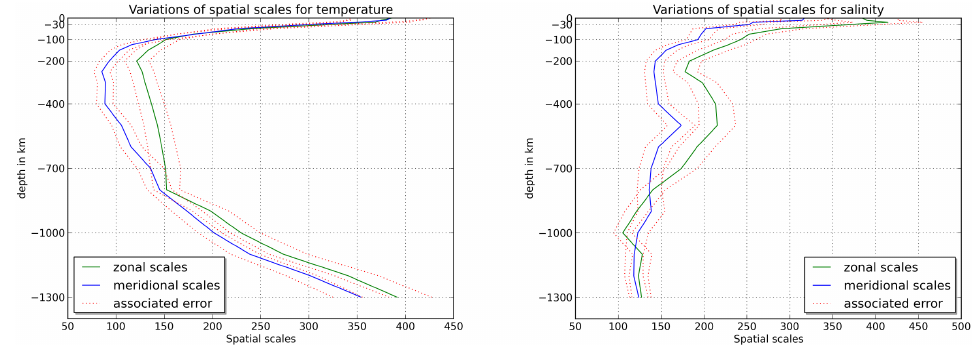
Figure 7. Variations of zonal and meridional spatial scales for temperature (left) and salinity (right) according to depth for box 18 (high- latitude Southern Hemisphere). Dotted lines represent standard fitting errors.